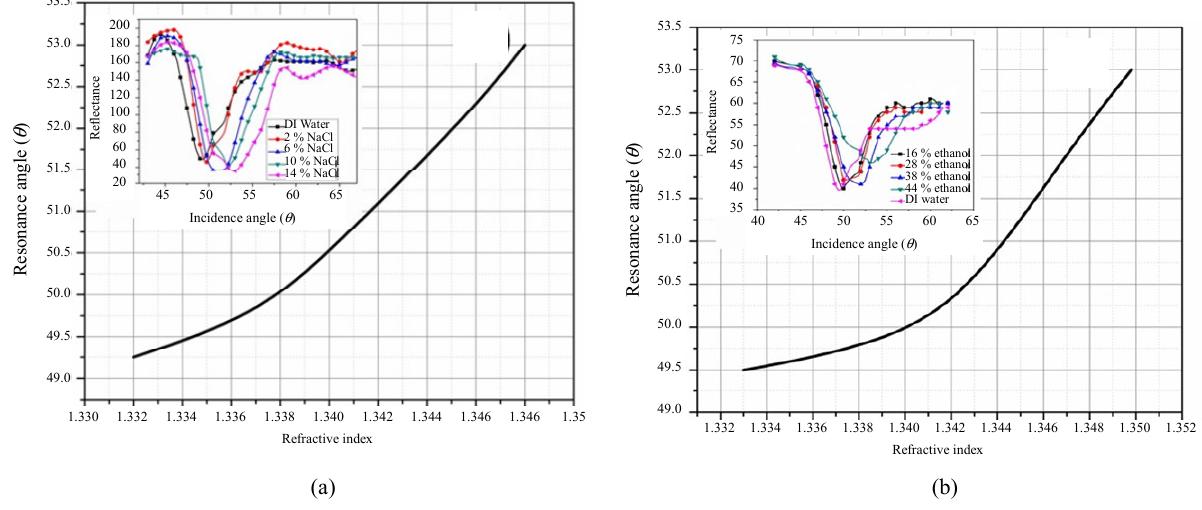
Fig. 5 Variation of SPR dip with refractive index using standard solution of sodium chloride (a) and ethanol (b).